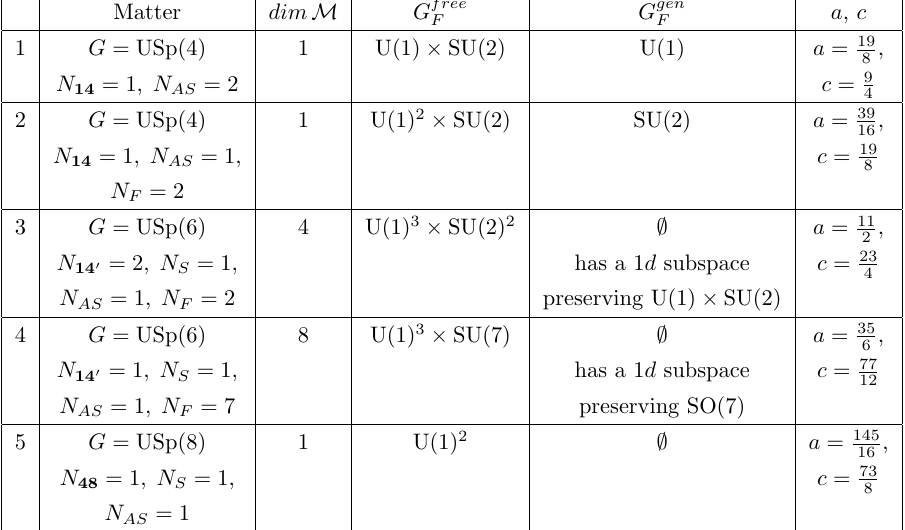
Table 16 . Cases involving a USp(2 N ) gauge group with ‘exotic’